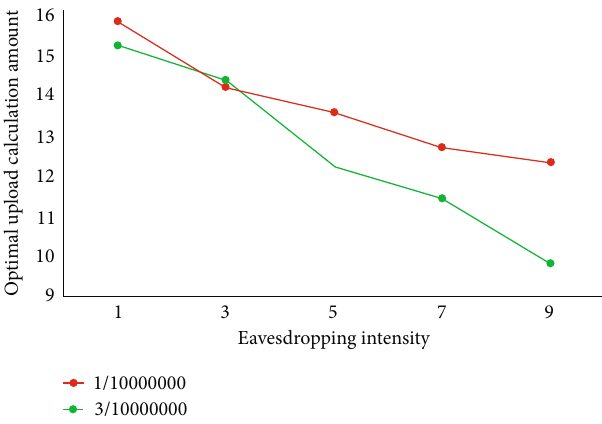
Figure 7: In fl uence of the change of eavesdropping intensity on the optimal upload